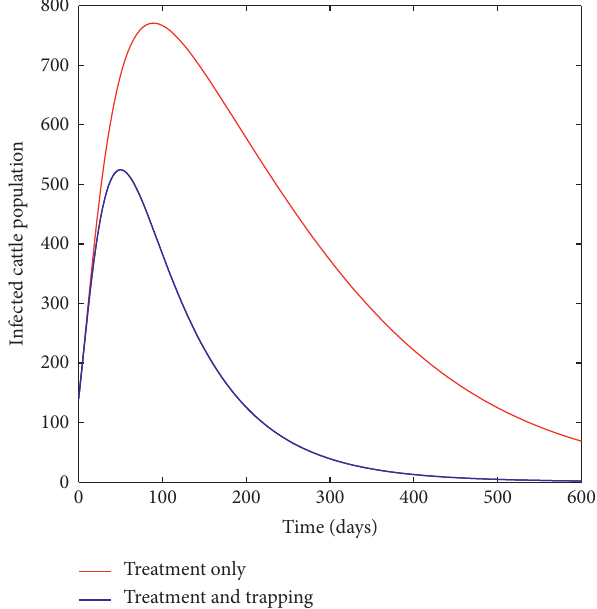
Figure 4: Impact of interventions on infected cattle population.